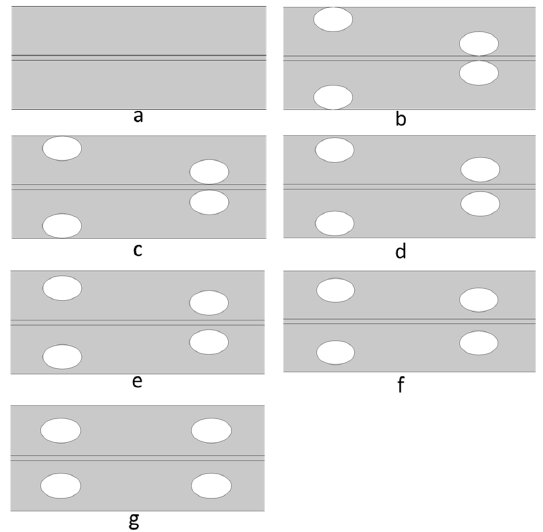
Figure 7. Illustration of ( a ) the empty channel, and spacer-filled membrane channels with different membrane–filament distances ( b ) 0, ( c ) 0.01, ( d ) 0.05, ( e ) 0.1, ( f ) 0.15, and ( g ) 0.25 mm. The center-to- center distance was 6 mm.